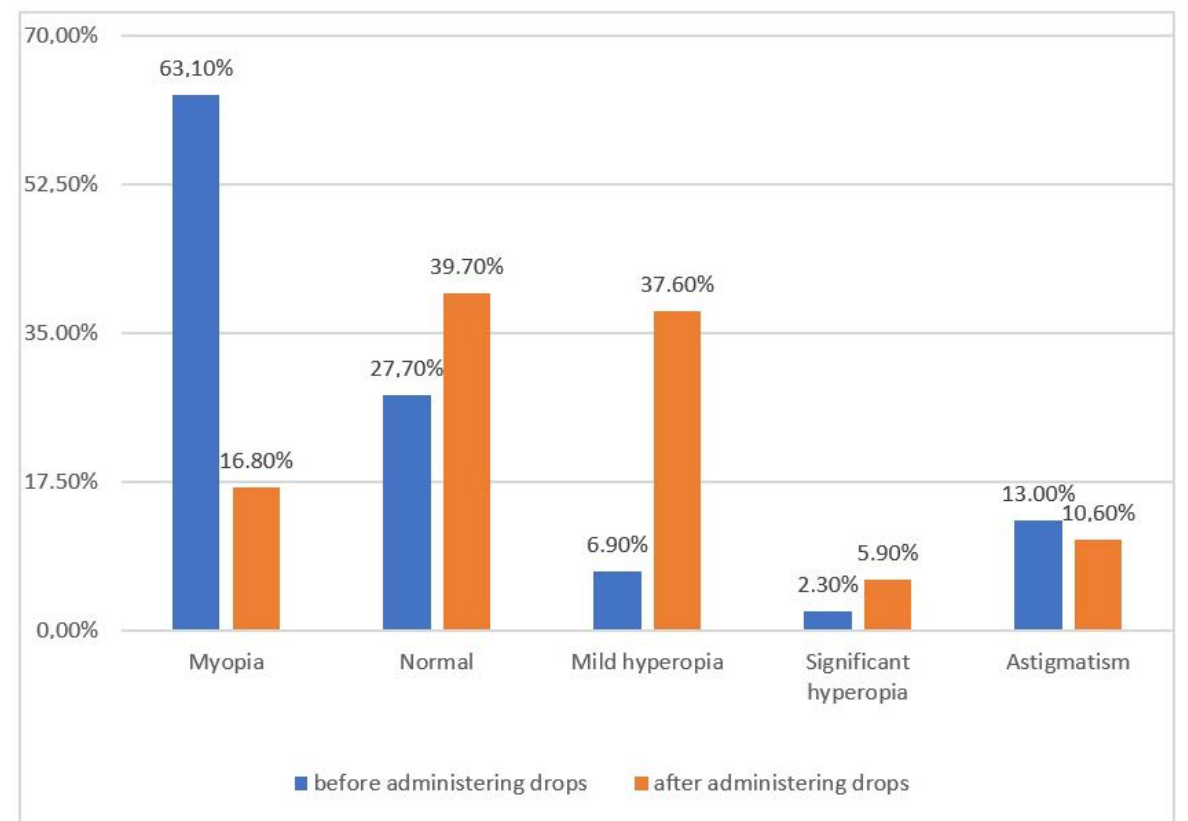
Figure 3. Difference in the magnitude of refractive errors before and after administration of accom- modative paralysis